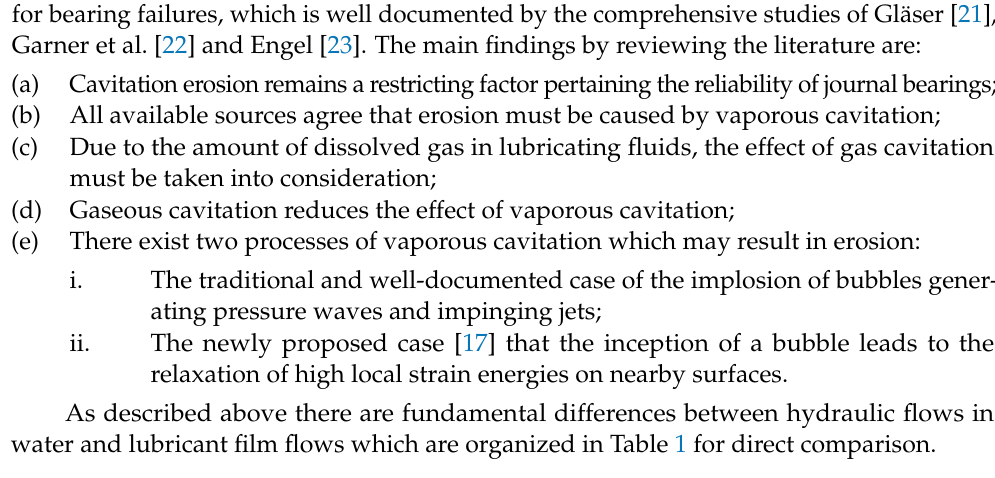
Table 1. Cavitation